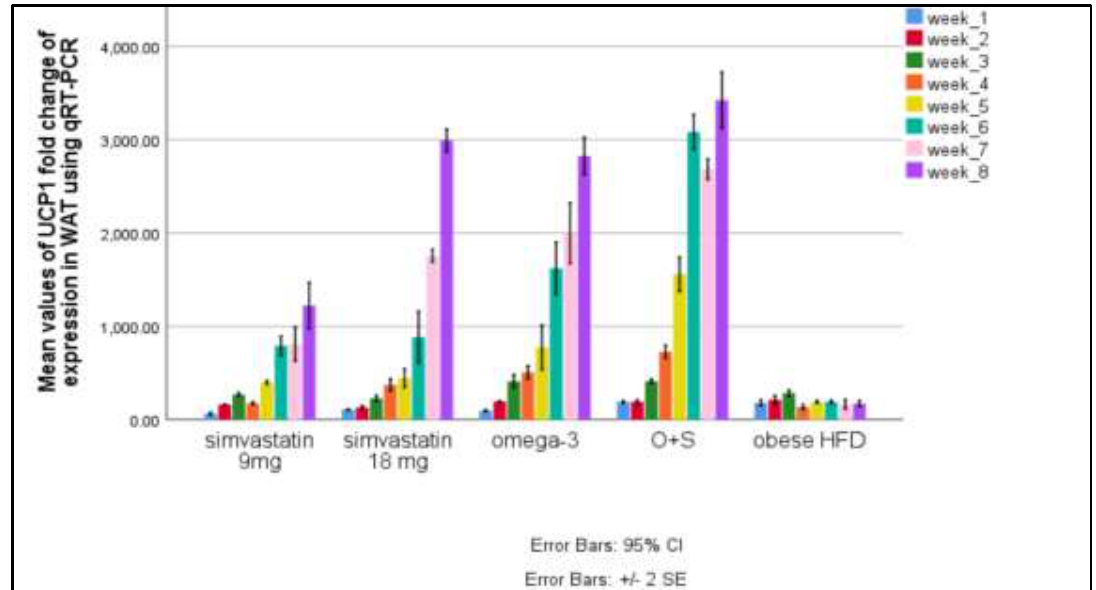
Figure 2. Effects of two-different doses of simvastatin, omega-3, and combination of simvastatin and omega3 on UCP 1 genes in white adipose tissue (WAT).